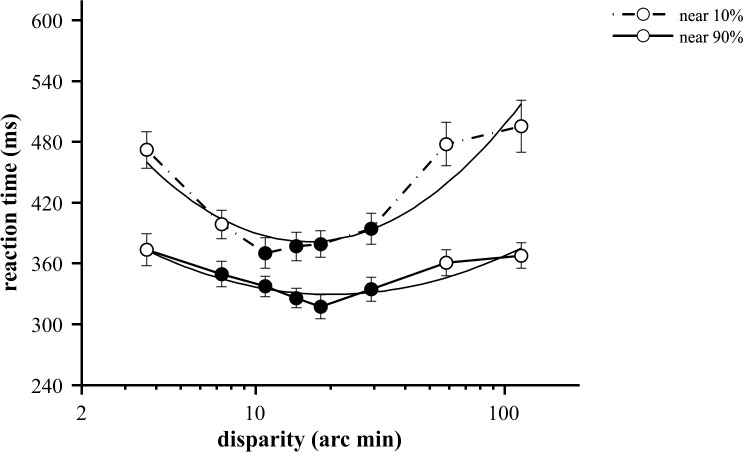
Mean reaction times for near disparity values at two (10% and 90%) contrast levels.Each data point represents the mean of 15 participants (at least 133 RTs); error bars show ±SEM. RTs formed statistically homogeneous groups for each contrast level. While the RTs (filled circles) were not significantly different from the shortest mean RT (370 ms for 10% and 317 ms for 90%), RTs signed open circles were not significantly different from the longest mean RTs (495 ms for 10% and 373 ms for 90% contrast), except 7.3 arc min at 10% contrast. Solid black curves show best fit 2nd order polynomial functions (R2 = 0.867, min. value = 16.3 arc min, equation = 186 * x2 − 450 * x + 654 or 10% and R2 = 0.833, min. value = 20.2 arc min, equation = 79 * x2 − 206 * x + 464 for 90% contrast).